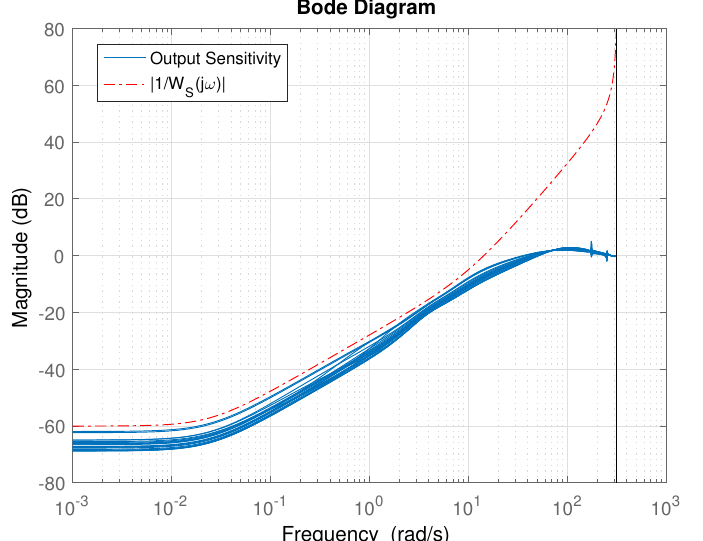
Figure 9. Controller gain.